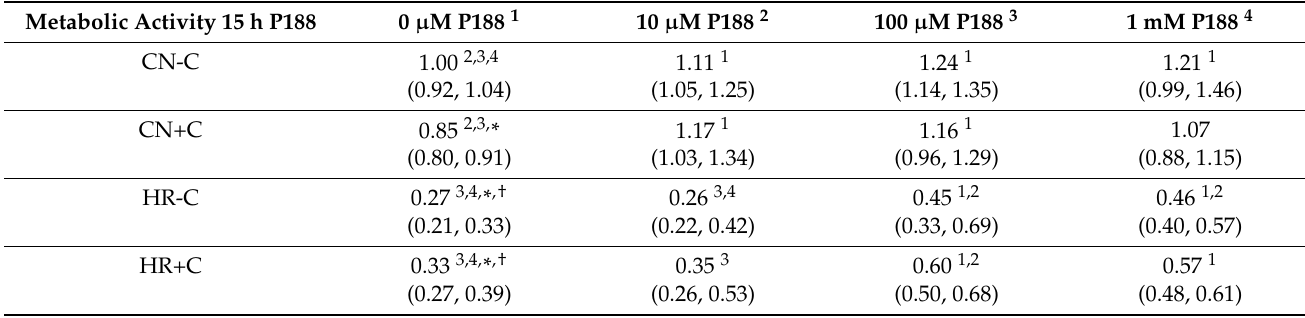
Table A7. Metabolic activity after 15 h injury and treatment with 0 µ M, 10 µ M, 100 µ M, and 1 mM of P188. Data from Figure A3 visualized as table (median, 25th, 75th percentile); p < 0.05; n = 4 experiments/group. Significances between different concentrations of P188 are displayed as superscripted numbers, significances between 0 µ M P188 CN-C, CN+C, HR-C, and HR+C are represented by symbols (* vs. CN-C 0 µ M P188, † vs. CN+C 0 µ M P188). Abbreviations: C, compression; CN, control/normoxia; h, hours; HR,